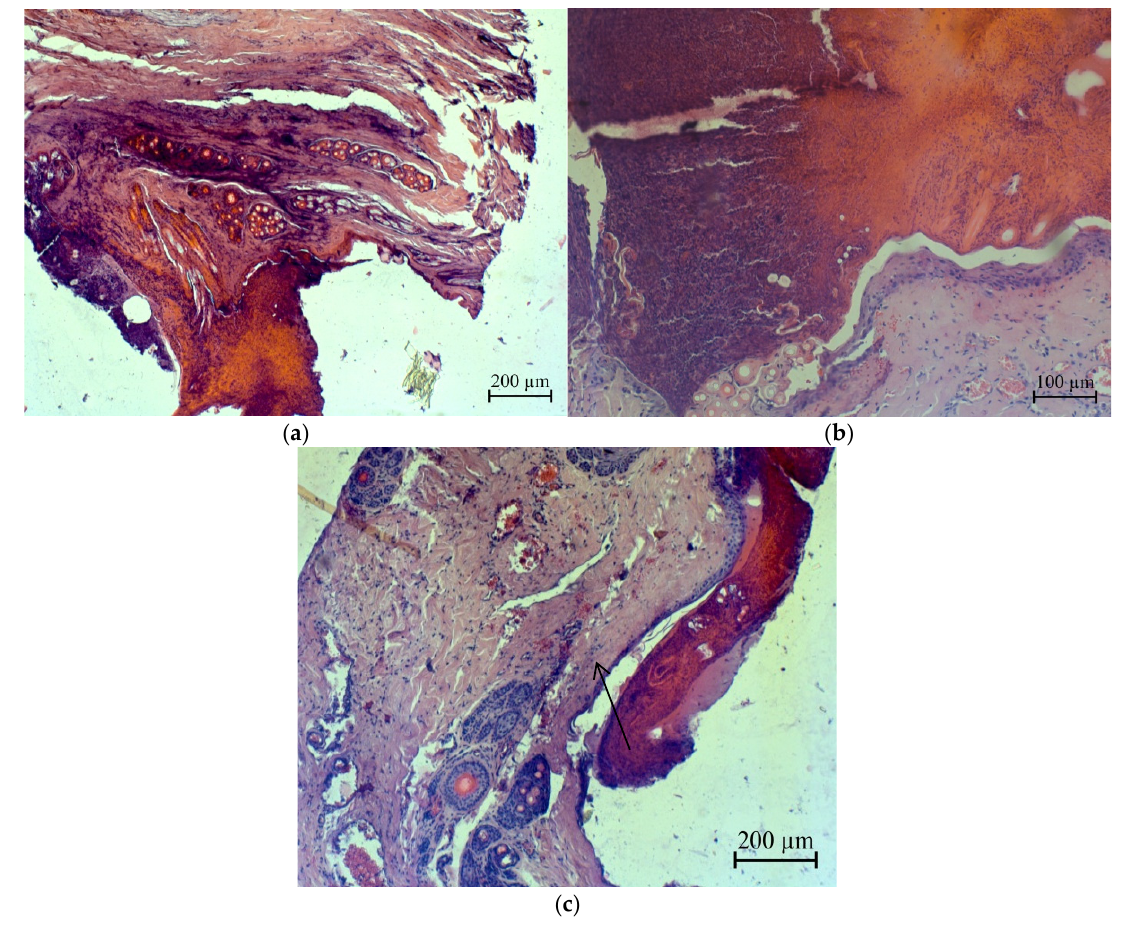
Figure 20. Micrographs of histological sections of postoperative wounds of laboratory animals: ( a )— the first group, ( b )—the second group and ( c )—the third group. Under the scab and in the tissues surrounding the wound canal, we observed exten ‐ sive cellular infiltrates, consisting mainly of macrophages, lymphocytes and new connec ‐ tive tissue cells. The width of extensive cellular infiltrates was approximately 300–350 μ m in animals of all experimental groups (Figure 21).